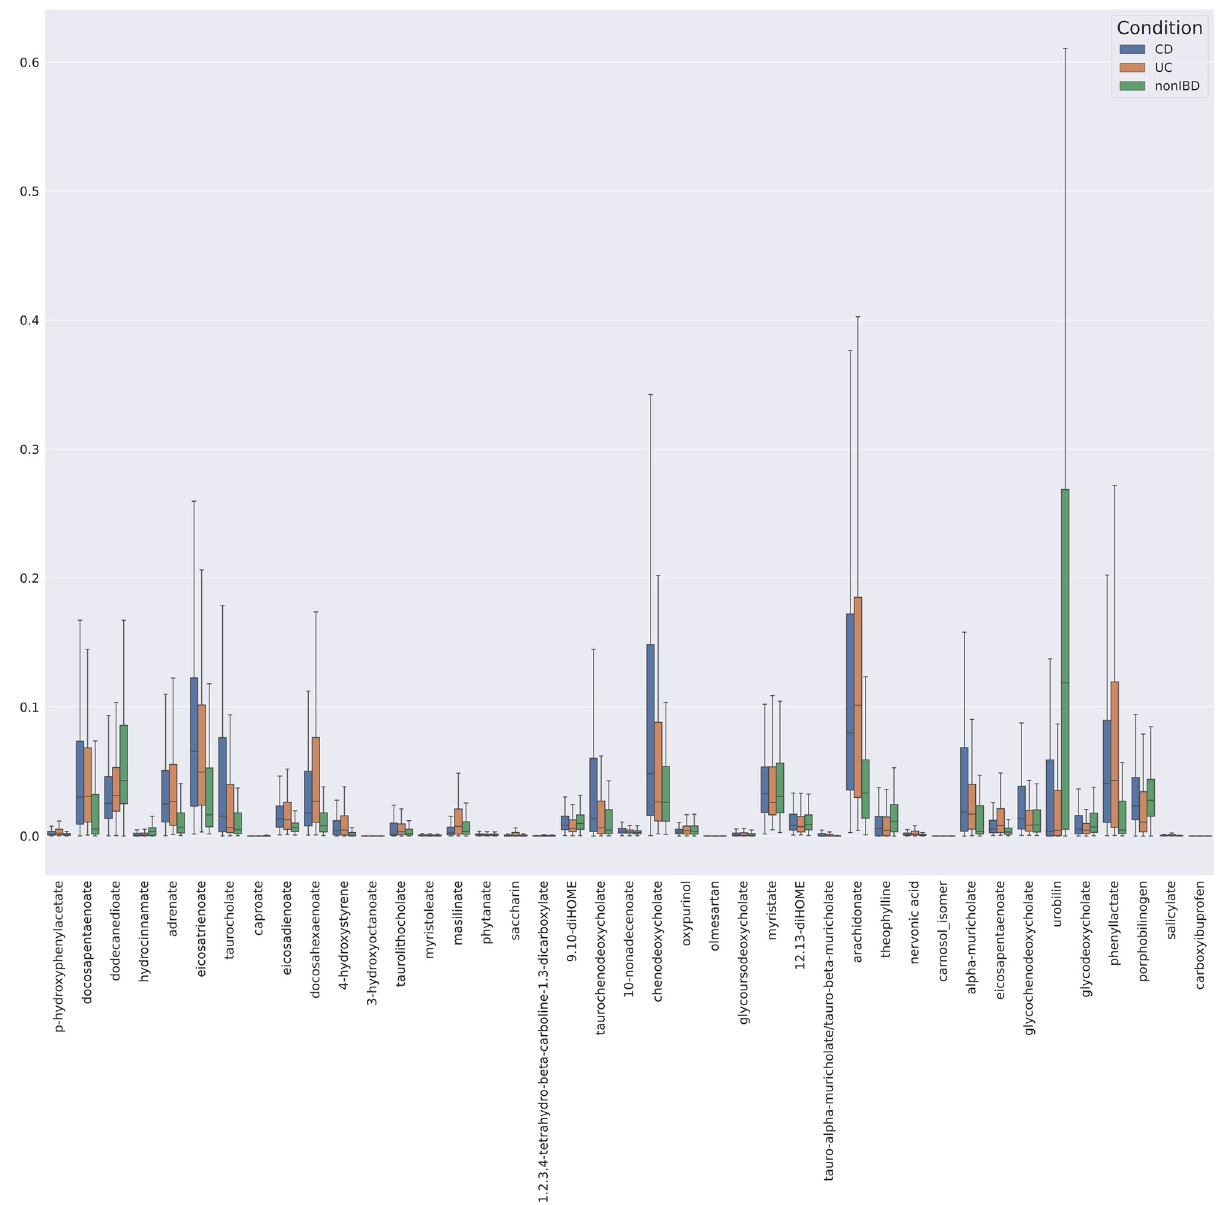
Fig 4. Boxplot of selected metabolites from C18 negative